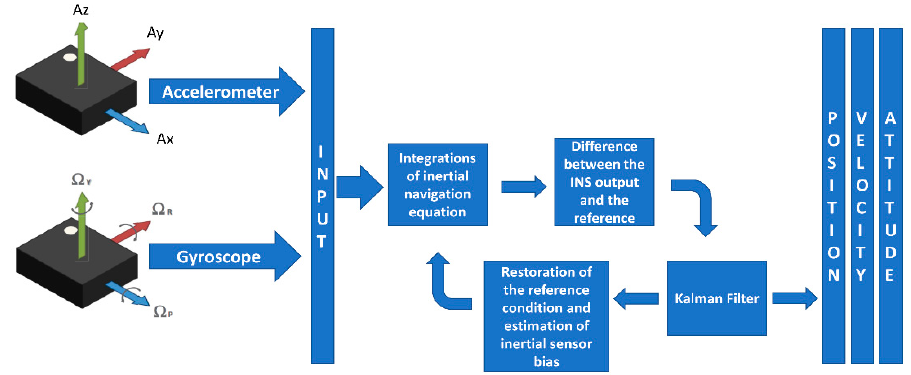
Figure 4. Initial bias estimation